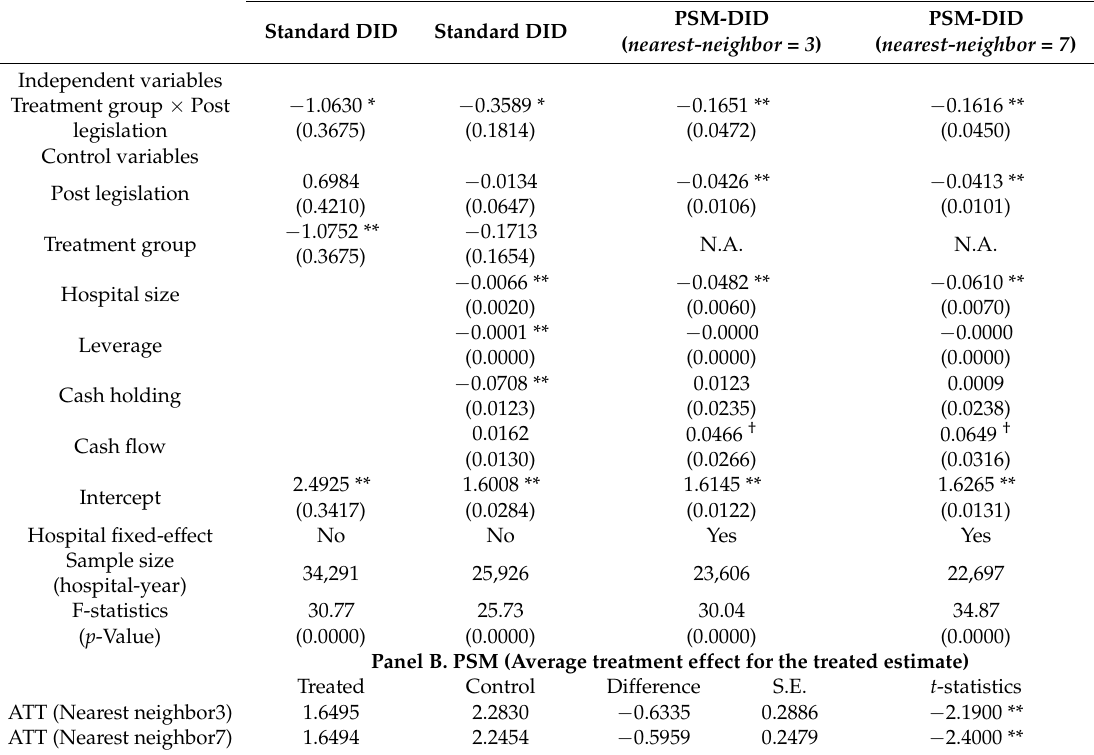
Table 1. The influence of the General Data Protection Regulation (GDPR) on financial performance of hospitals in the European